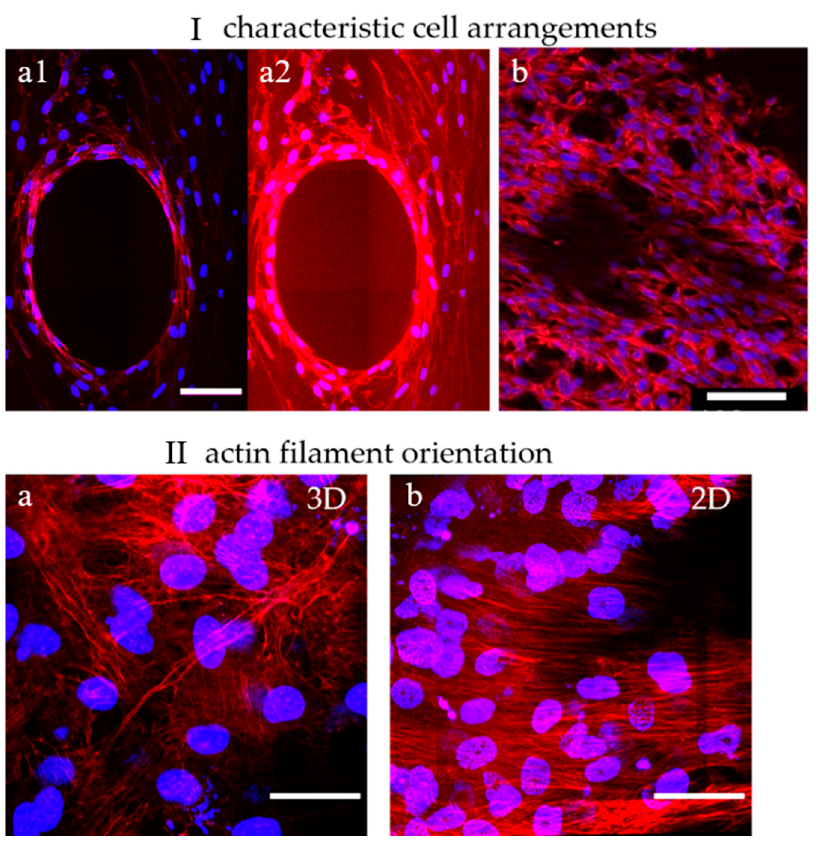
Figure 5. Dual-labeled MC3T3-E1 cells exemplify both cell distribution and structural features of the formed tissues within the scaffolds. ( I ) Characteristic cell arrangements in α -TCP/HA and baghdadite scaffolds. ( a1 , a2 ): The concentric arrangement of actin filament networks in the center of a partially populated scaffold pore reveals how cells are spatially ordered. ( b ): Away from that location, unconstrained spatial networks of cells were present. ( II ) Actin filament orientation in 3D and 2D regions. ( a ): In a 3D cell environment, a multidirectional orientation of actin filaments was present ( α -TCP/HA and baghdadite scaffolds). ( b ) On a 2D surface (shown here: surfaces of α -TCP/HA discs), a unidirectional orientation of filaments was observed. Scale bars: ( I ): 100 µm and ( II ): 50 µm. All presented images are representative of ten replicate recordings.